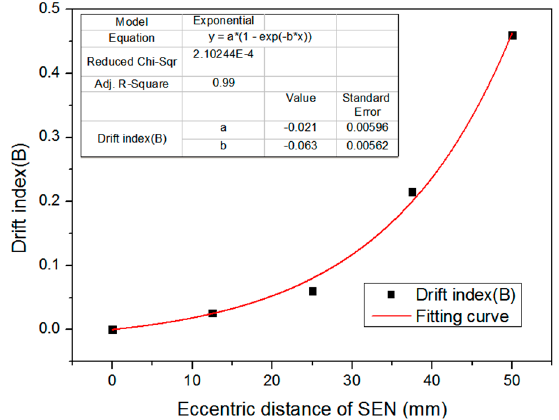
Figure 10. The e ff ect of eccentric distance on the drift index. Figure 10. The effect of eccentric distance on the drift index.